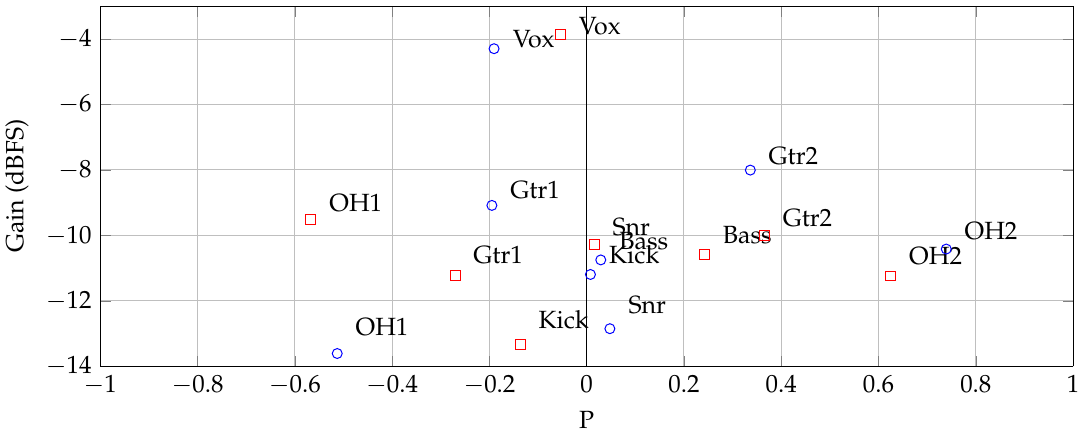
Figure 11. Two random mixes generated using panning method 2, shown as squares and circles. Each mix has a different gain vector (based on Equation (7) and different pan vector (based on Equation (13).